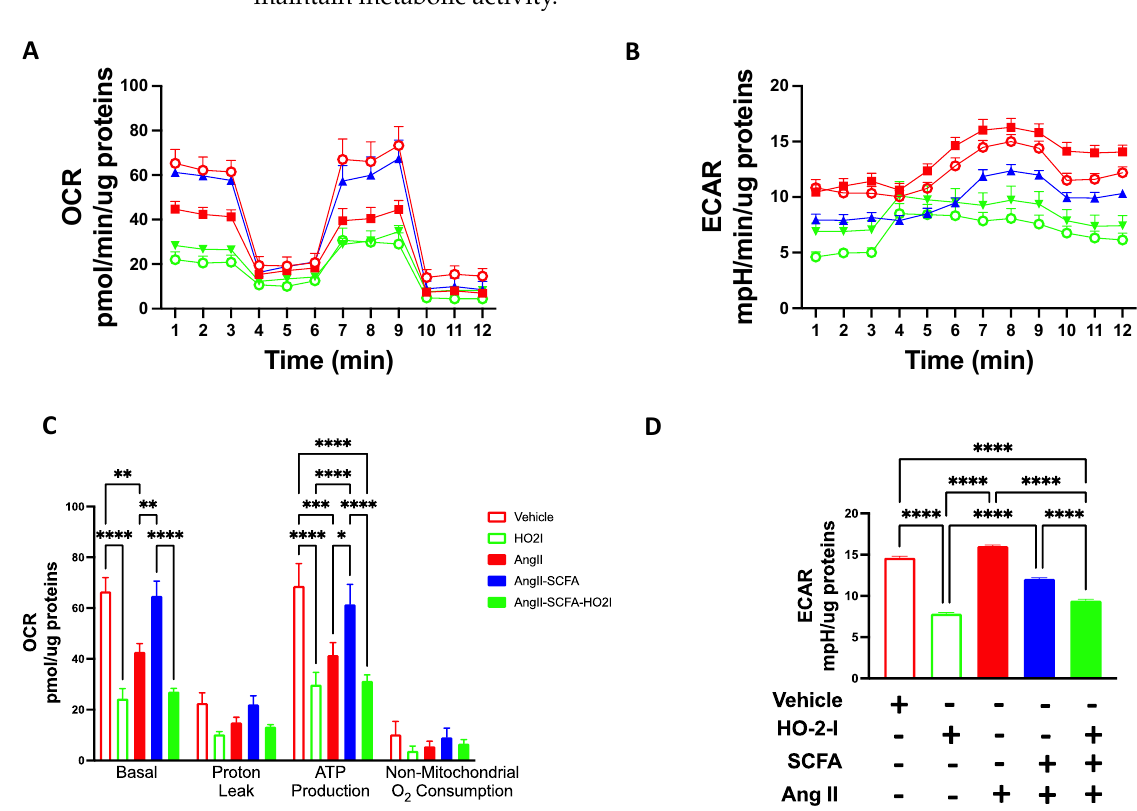
Figure 7. SCFAs rescued Ang-II-induced mitochondrial respiration impairment. OCR ( A , C ) and ECAR ( B , D ) show that Ang-II-induced changes in OCR and ECAR in brain microvascular endothelial cells were reversed by the SCFAs/HO-2 axis. * p < 0.05; ** p < 0.01; *** p < 0.001; **** p < 0.0001. N = 50,000 cells per well/four different experiments. SCFAs: short-chain fatty acids; Ang II: angiotensin II; HO-2 I: heme oxygenase 2 inhibitor; OCR: oxygen consumption rates; ECAR: extracellular acidification rate.